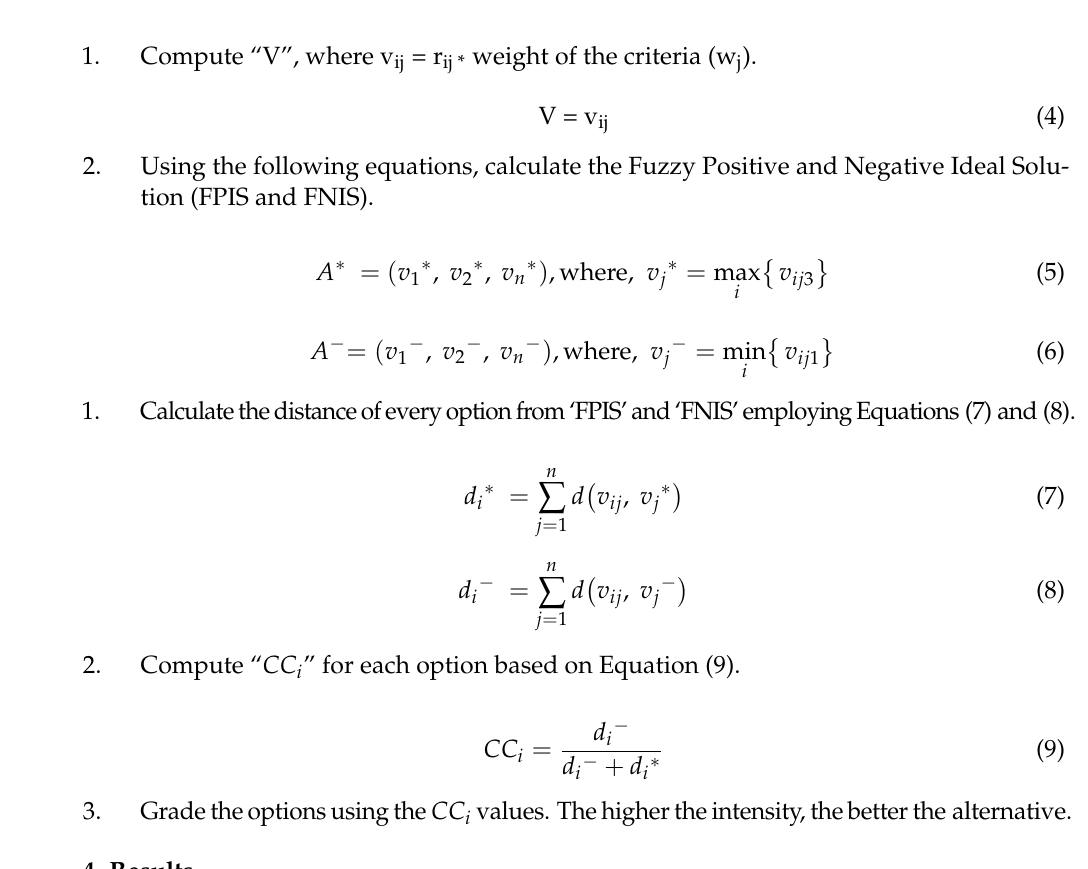
Table 3. Parameters along with their term sets and membership functions.